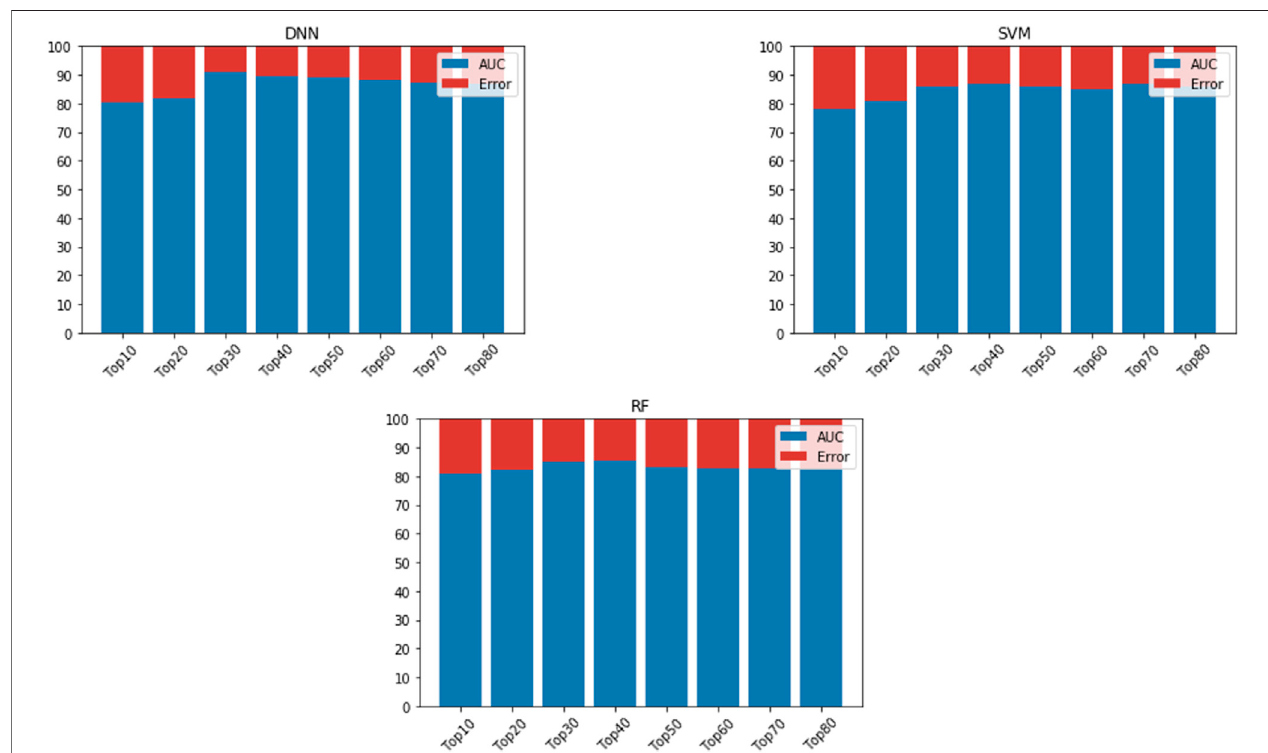
FIGURE 3 | AUC is based on different numbers of featured genes using DNN, SVM, and RF. AUC is indicated in blue, while error rate is indicated in red.